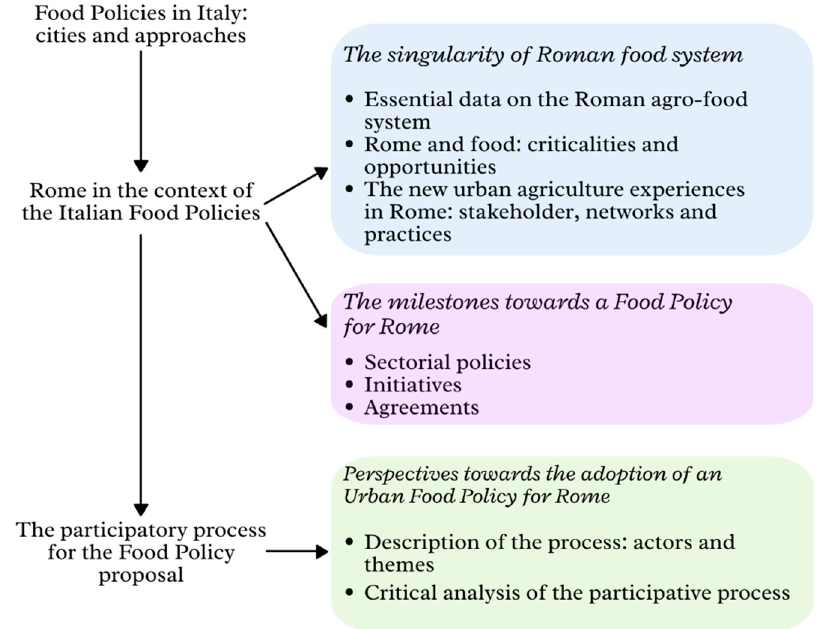
Figure 1. Research design (source: our elaborations).